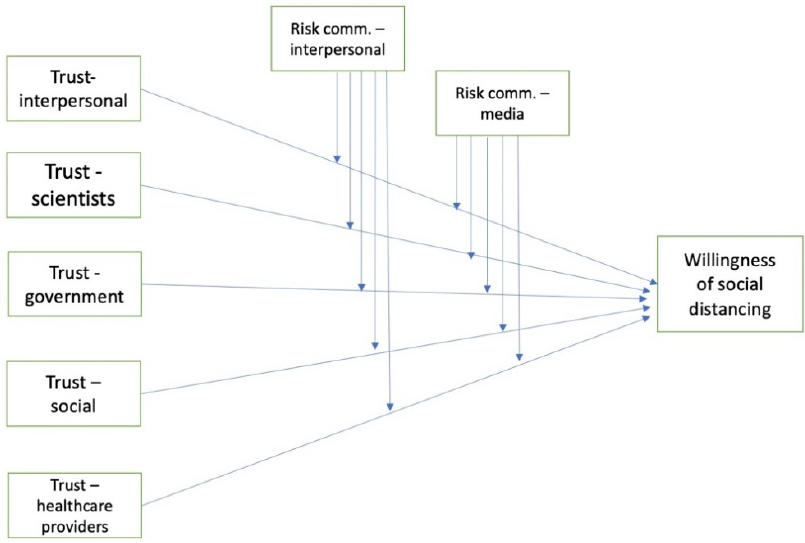
Figure 1. Conceptual model of the relationships between variables to be tested.